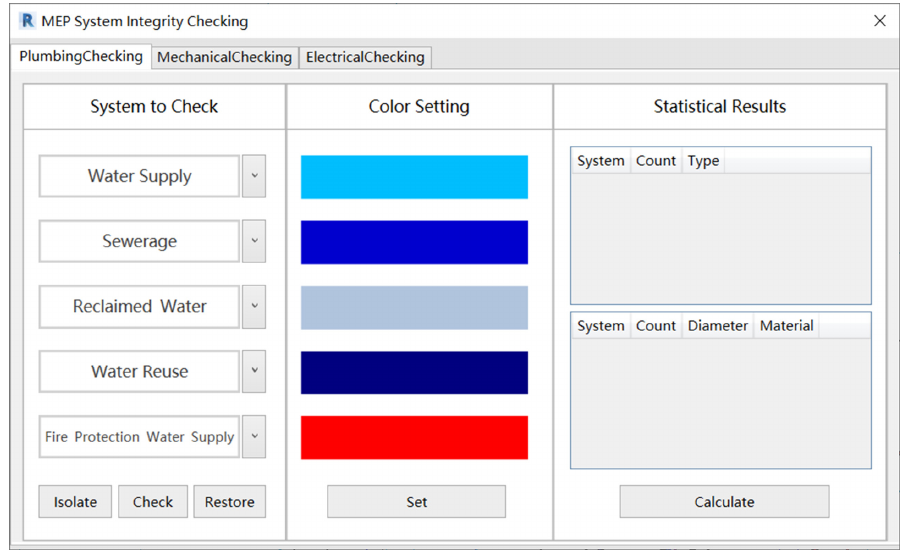
Figure 13. The user interface of MEP Systems integrity